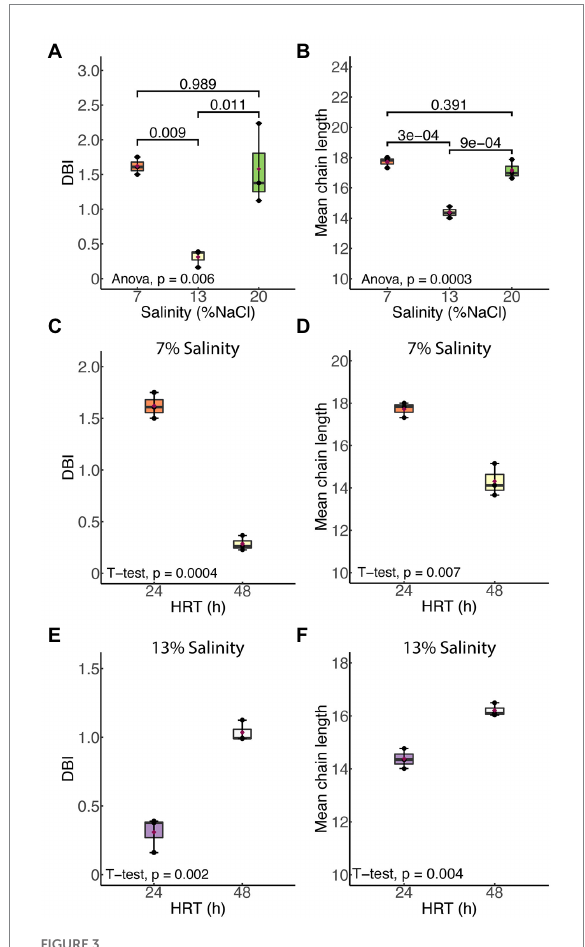
FIGURE 3 Mean chain length (MCL) and double bond index (DBI) of membrane phospholipids in H. congolense WG10 responded distinctly to salinity (A,B) and hydraulic retention time (HRT). The effect of HRT was evaluated at two discrete salinities – 7% (C,D) and 13% (E,F) . p -Values are obtained from one-way ANOVA of multiple independent groups or Student’s t -test of two independent groups. Variation is considered statistically significant at α ≤